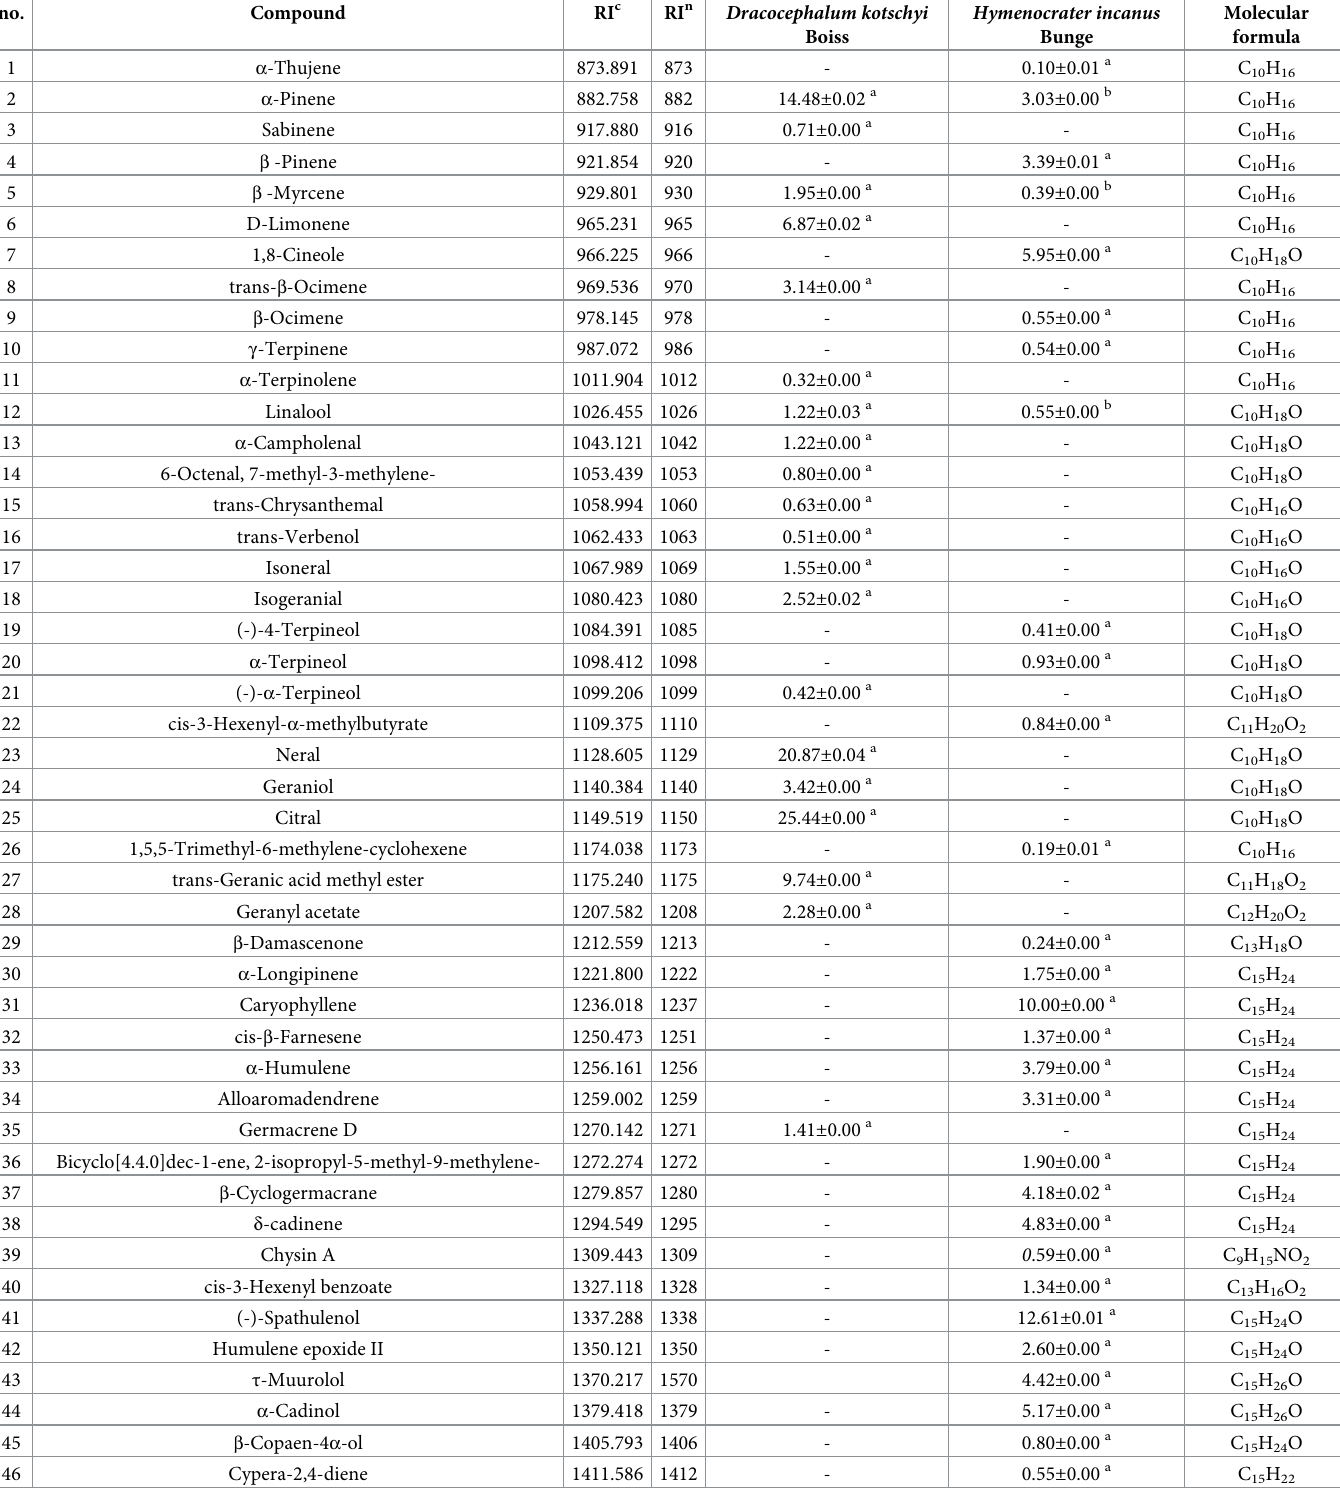
Table 1. The chemical composition of essential oil of H . incanus and D . kotschyi